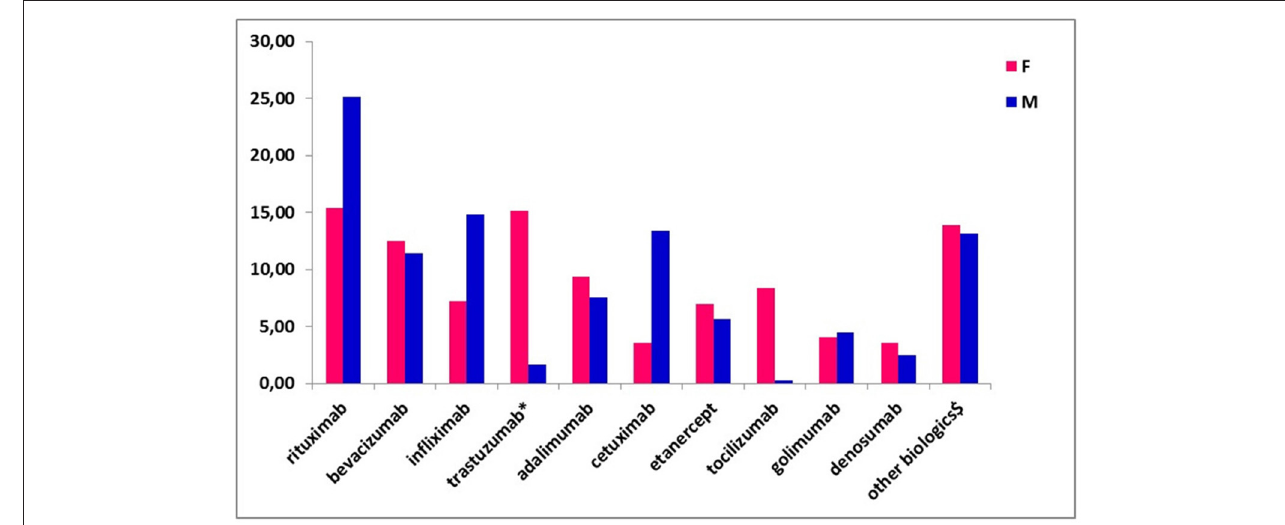
FIGURE 1 | Biotech drug distribution by gender.